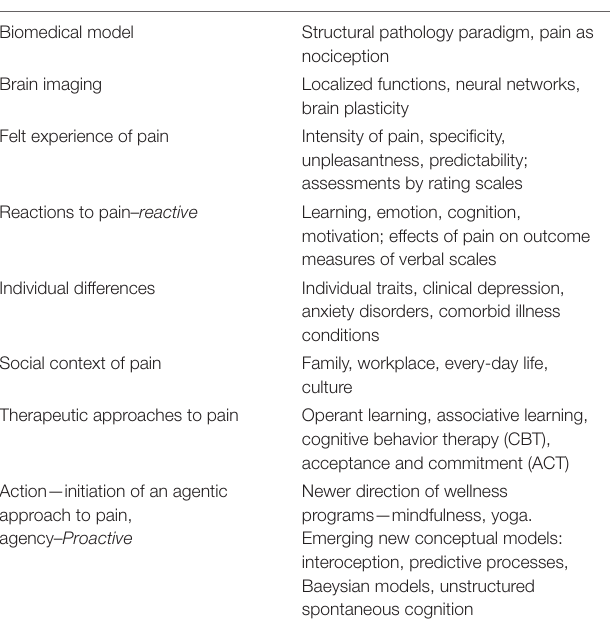
TABLE 4 | Overview of main content areas covering research approaches in the study of pain. Research domains for investigations and interventions of chronic pain Biomedical